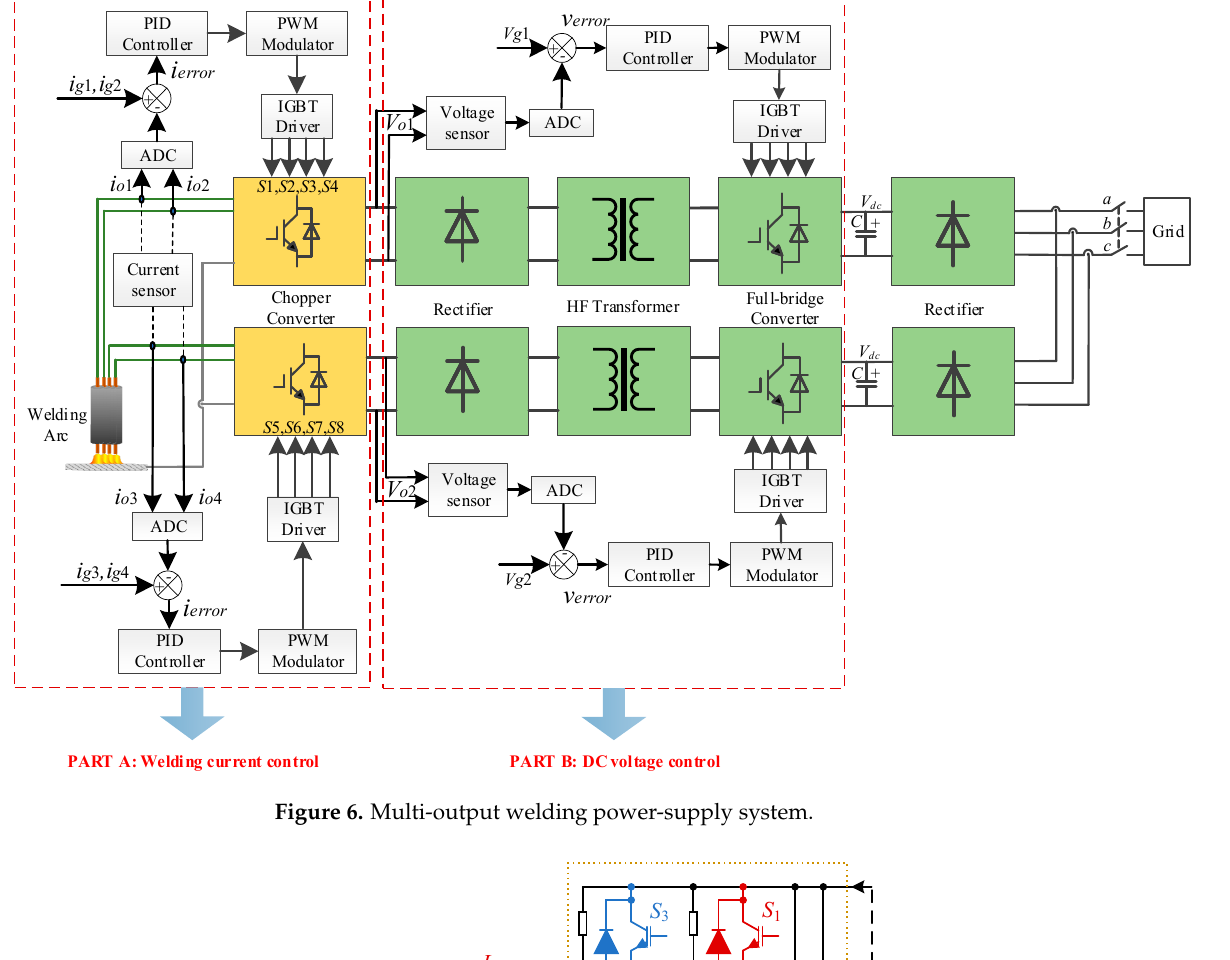
Figure 6. Multi-output welding power-supply system.